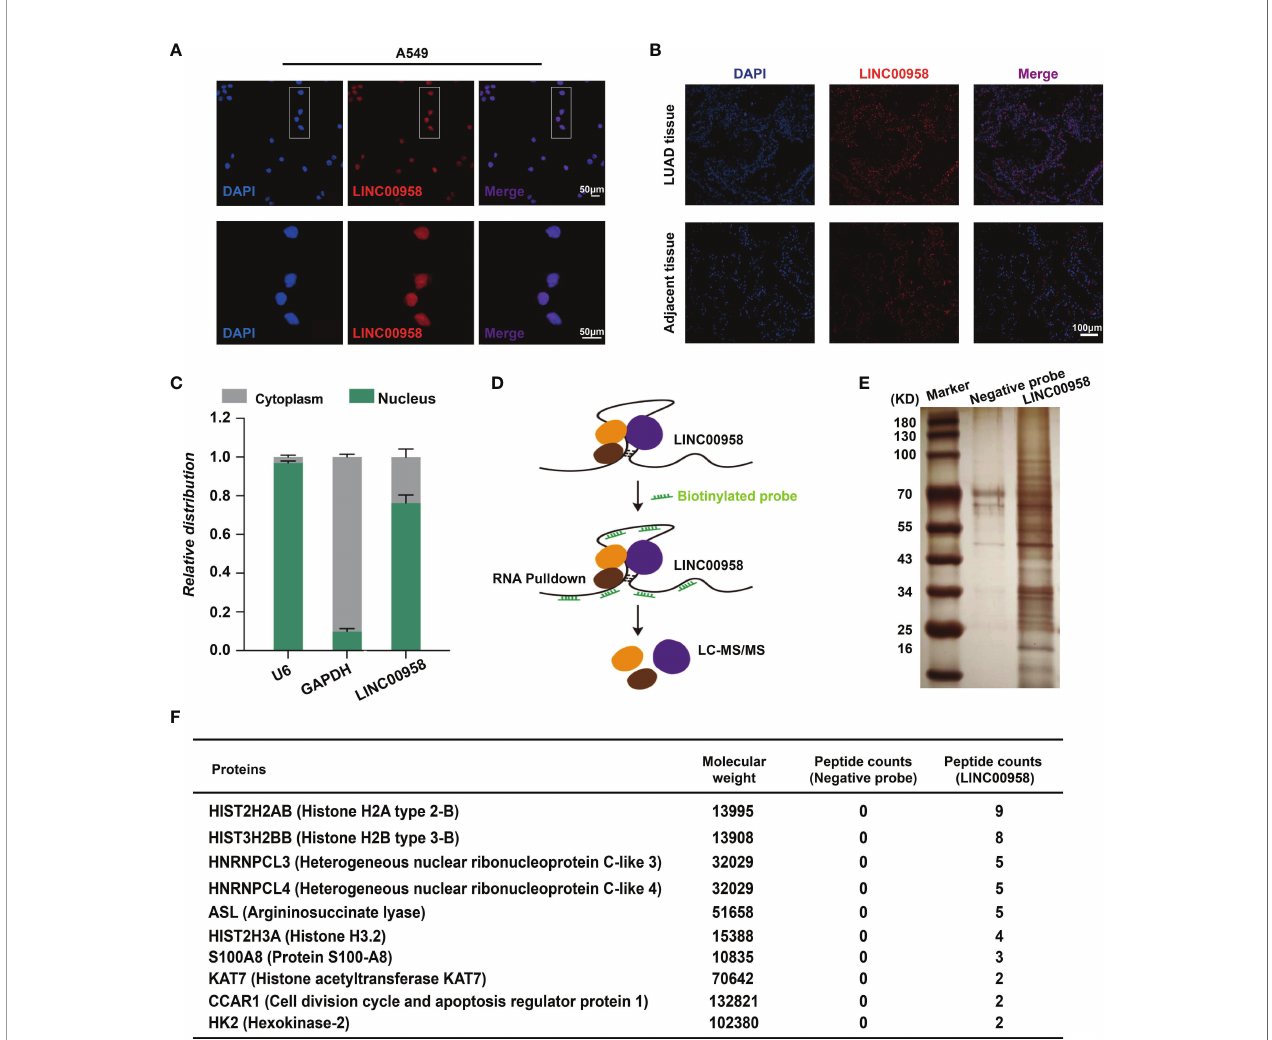
FIGURE 5 | LINC00958 interacted with histones in lung adenocarcinoma (LUAD) cells. (A) Distribution of LINC00958 in A549 cells (Scale bar, 50 m m). A549 cells were subjected to fl uorescent in situ hybridization (FISH) analysis using probes against LINC00958. (B) Distribution of LINC00958 in LUAD tissue was analyzed using immuno fl uorescence (Scale bar, 100 m m). LUAD tissues were subjected to FISH analysis. (C) The expression of LINC00958 in A549 cells was examined using quantitative real-time polymerase chain reaction. The expression of LINC00958 in the nuclear and cytoplasmic fractions was determined. GAPDH and U6 were used as markers for the cytoplasmic and nuclear RNAs, respectively. (D) Schematic illustration of the RNA pull-down assay. (E, F) Silver staining (E) and illustration (F) of LINC00958-interacting